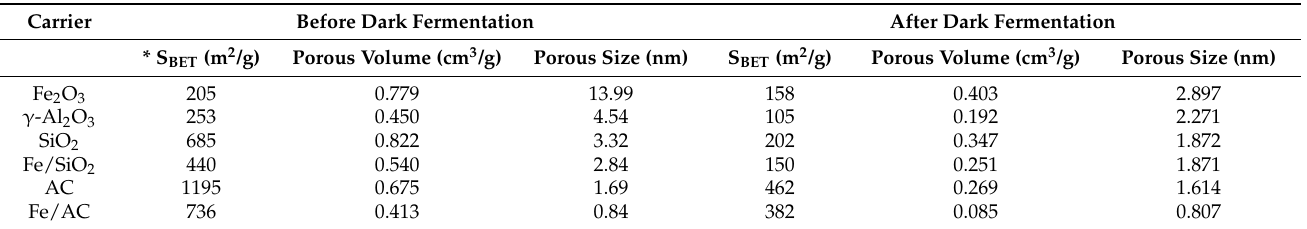
Table 1. Textural properties of the Enterobacter spH1 and Citrobacter freundii H3 co-culture supports used in the dark